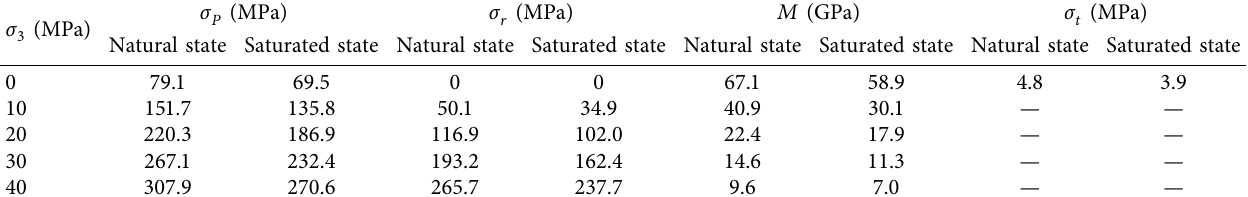
Table 4: Strength parameters of Yunnan limestone under natural and saturated